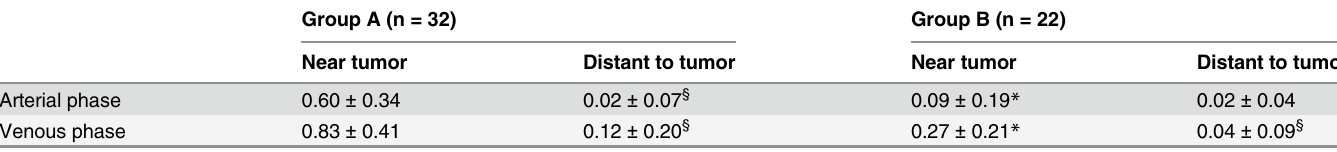
Table 3. Iodine concentrations in the perigastric adipose tissue of patients in groups A and B, measured using